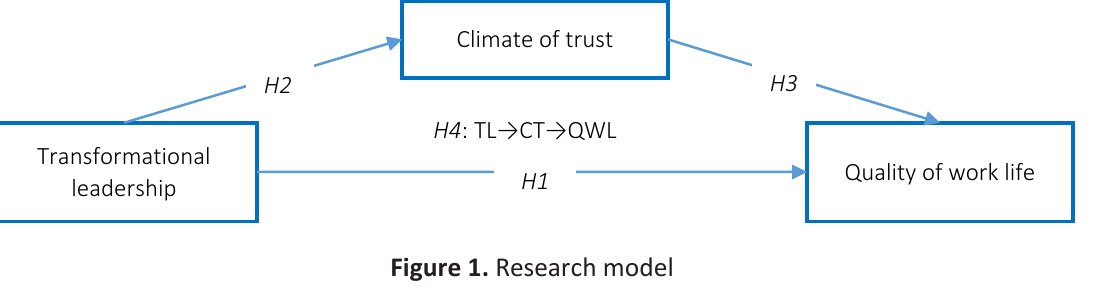
Figure 1. Research